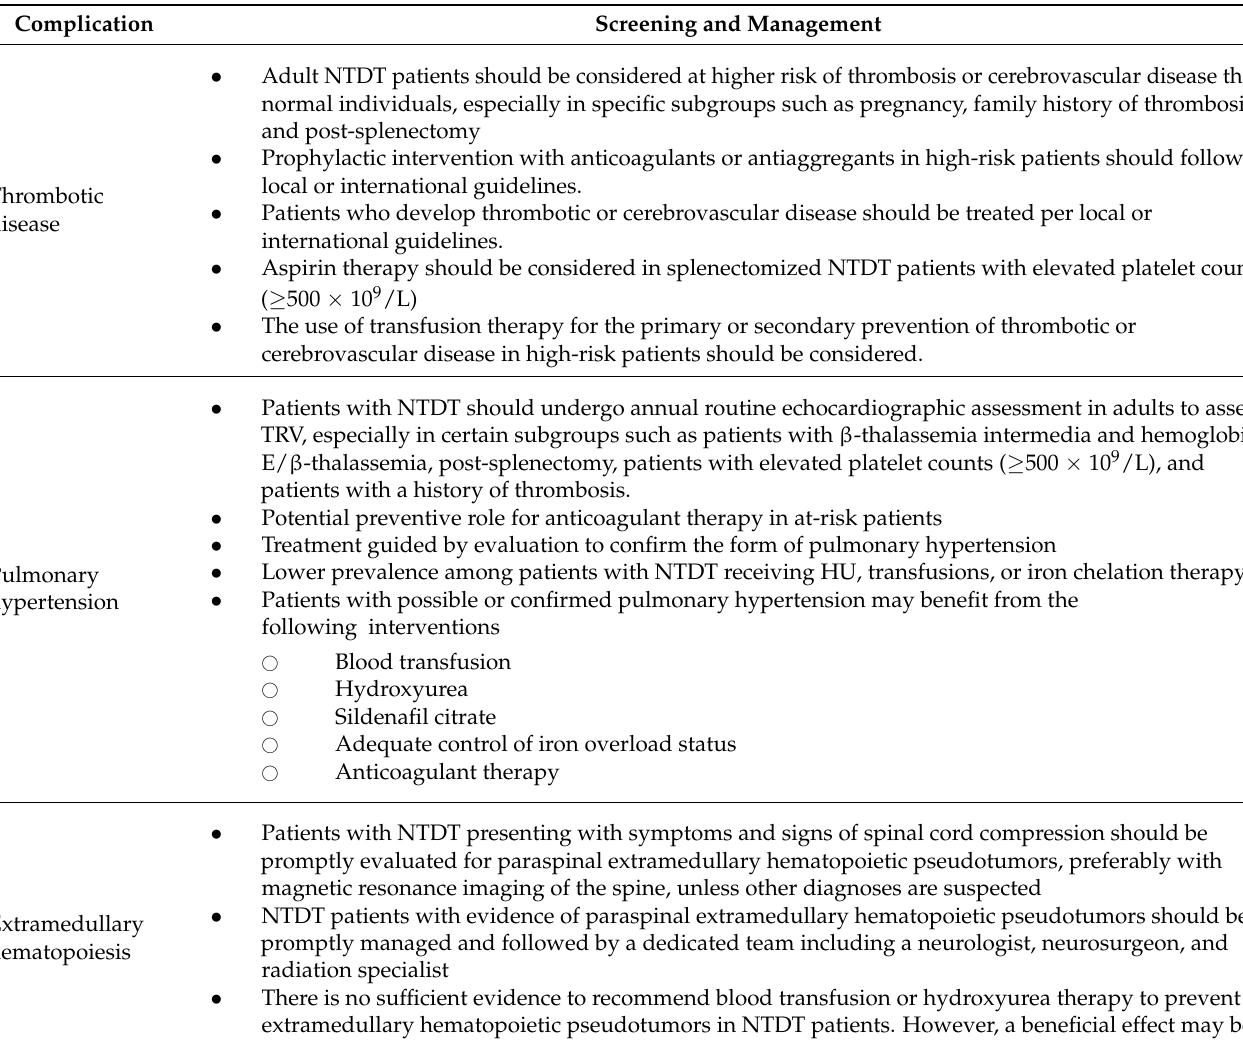
Table 3. Management of specific complications in NTDT